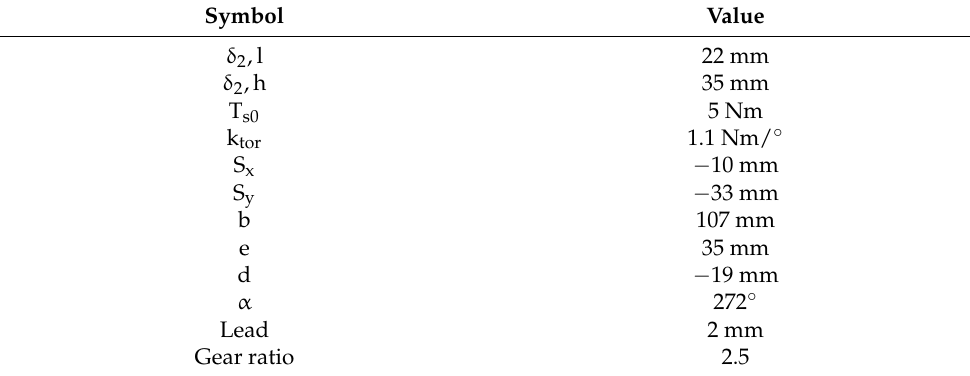
Table 2. Parameters for Torsional